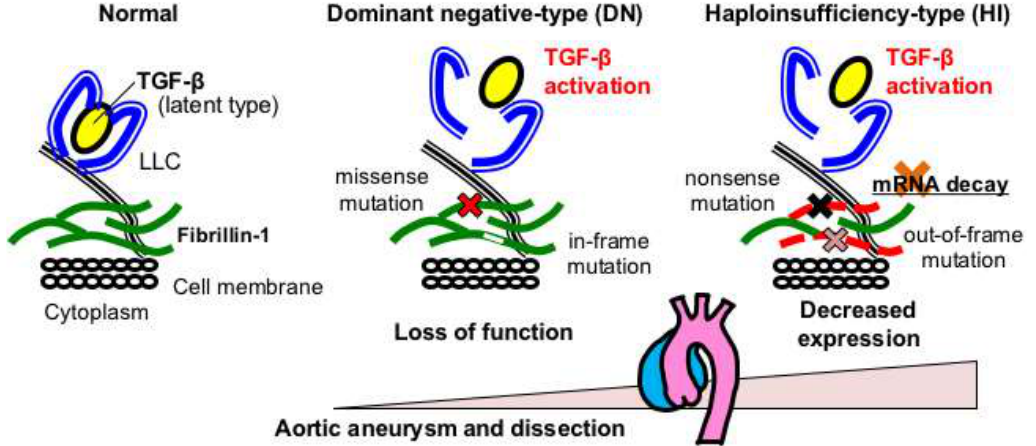
Figure 2. FBN1 genotypes and aortopathy in MFS. Haploinsufficient (HI)-type variants, such as nonsense and out-of-frame variants that presumably cause nonsense-mediated mRNA decay (NMD), result in more severe aortic phenotypes than those with dominant negative (DN)-type variants, such as missense and in-frame variants that are expected to exert loss-of-function